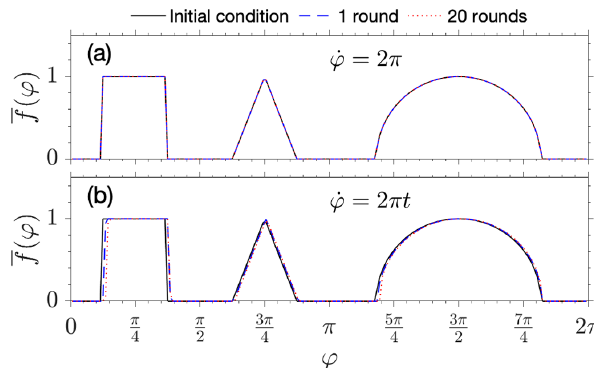
Figure 4. (a) Initial condition (solid black line) and UBER solutions of Eqs. (32) and (33) for a constant drift frequency after 1 round ( T = 1, blue dashed line) and 20 rounds ( T = 20, red dotted line) of drift around Earth. (b) Initial condition and UBER solutions of the same problem but with an accelerating drift frequency after 1 round √ √ ( T = 2) and 20 rounds ( T = 2 10) of drift around